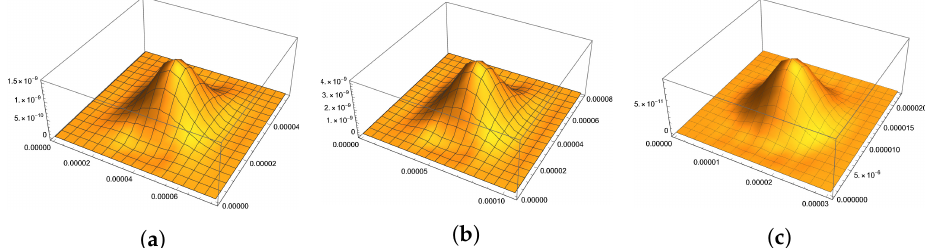
Figure 14. Influence of the thickness. ( a ) Recovered load. Plate thickness h 0 = 5 l 0 . Relative error Error R = 0.091. ( b ) Recovered load. Plate thickness h 0 = 7 l 0 . Relative error Error R = 0.11. ( c ) Recovered load. Plate thickness h 0 = 2 l 0 . Relative error Error R =